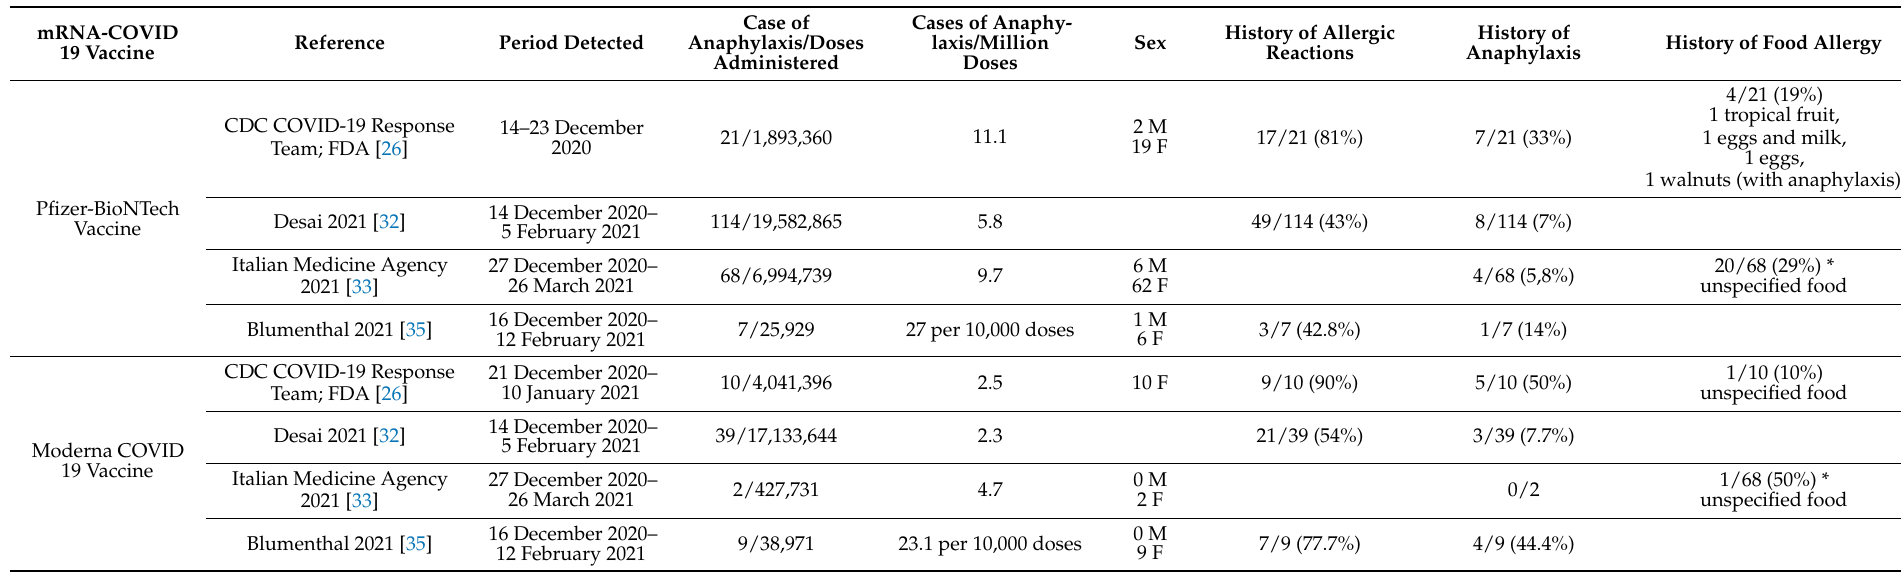
Table 2. Characteristics of reported cases of anaphylaxis following mRNA COVID-19 vaccine. * Combined data of food allergy, insect venoms,